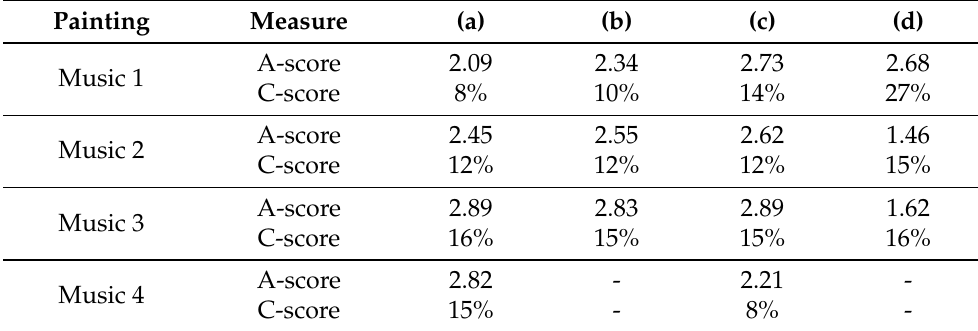
Table 8. Results of the inverse implicit multi-sensory concordance experiment. The A-score is the agreement scale and the C-score is the cosine